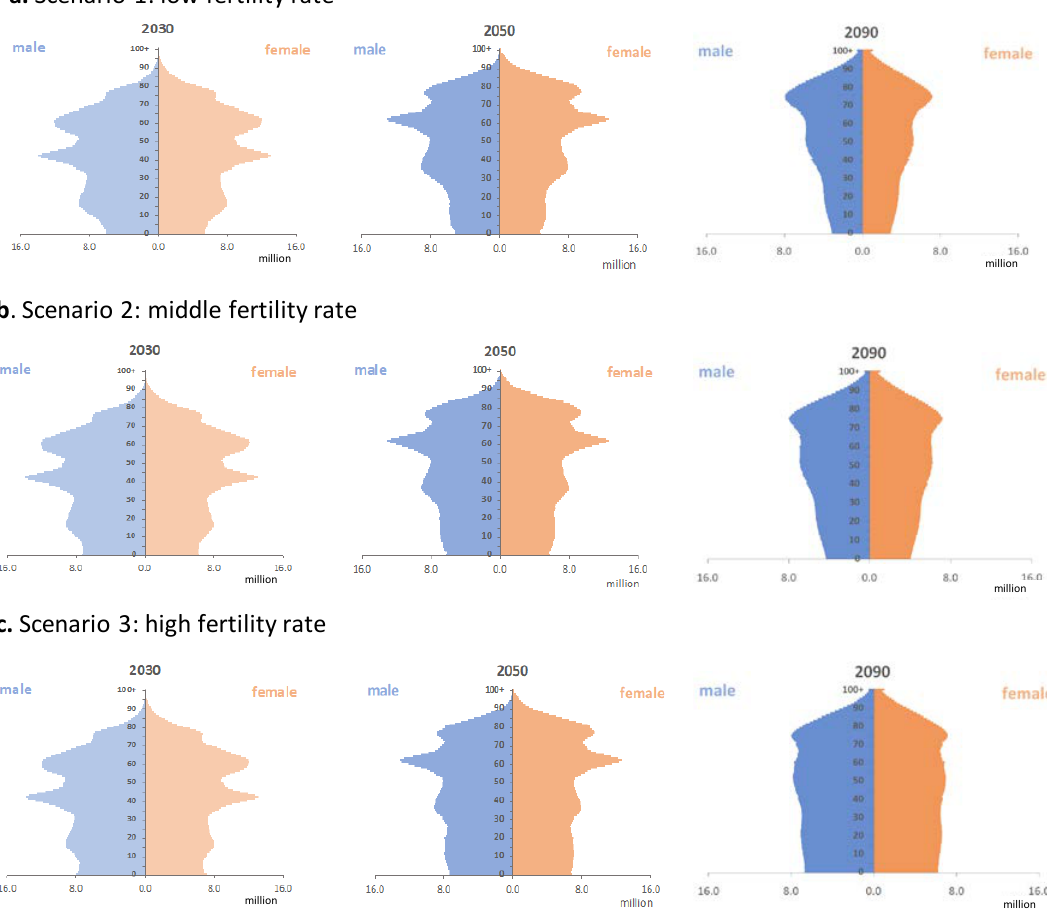
Figure 3. Population pyramids under different scenarios: ( a ) scenario 1 with a low fertility rate; ( b ) scenario 2 with a middle fertility rate; ( c ) scenario 3 with a high fertility rate.